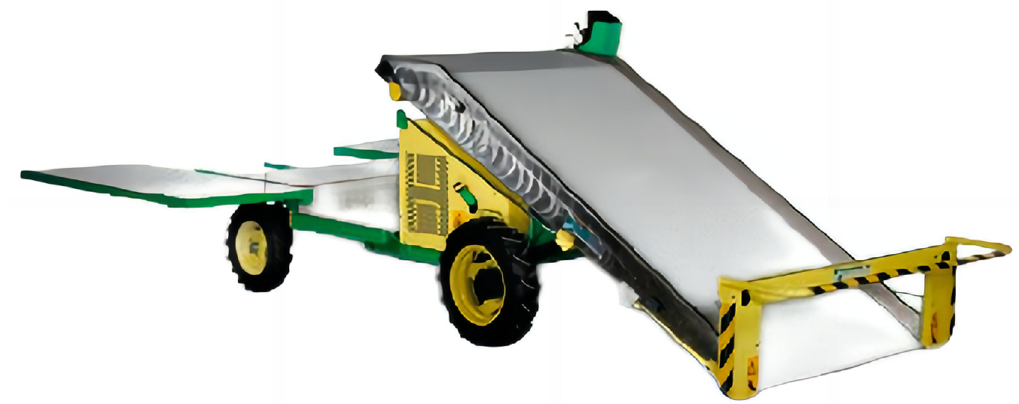
Figure 1. SLIDE FW leafy vegetable harvester.